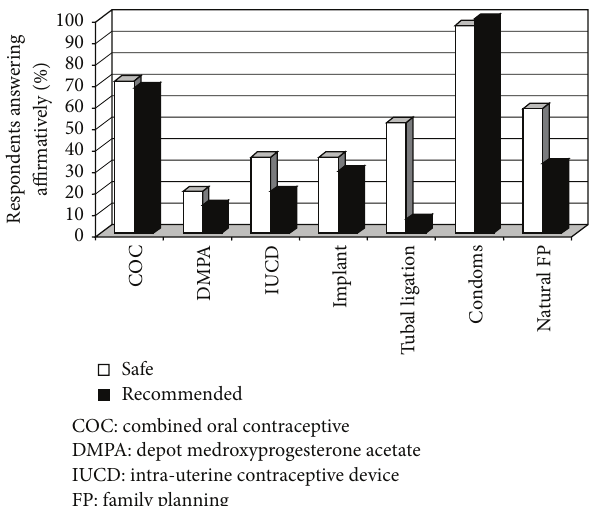
Figure 1: Contraceptive safety knowledge and recommendation of contraceptive methods among HIV care providers in Nyanza Province, Kenya ( 𝑁 = 31